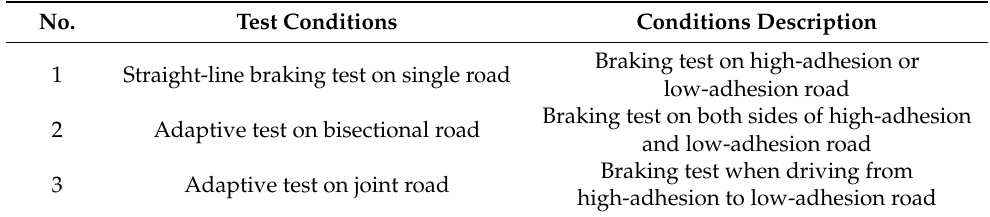
Table 1. Recommended test conditions in GB13594-2003. No. Test Conditions Conditions